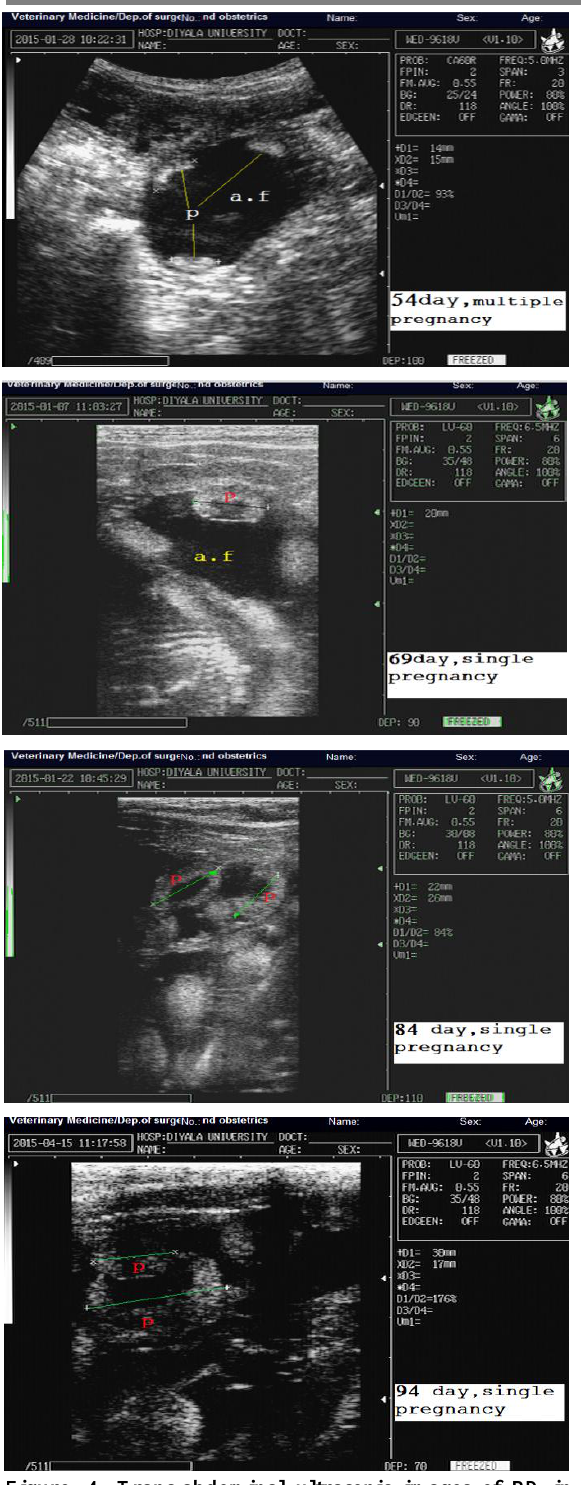
Figure, 4: Trans-abdominal ultrasonic images of PD in single pregnancy. P : placentomes, a.f: Allantoic fluid. (Linear probe).